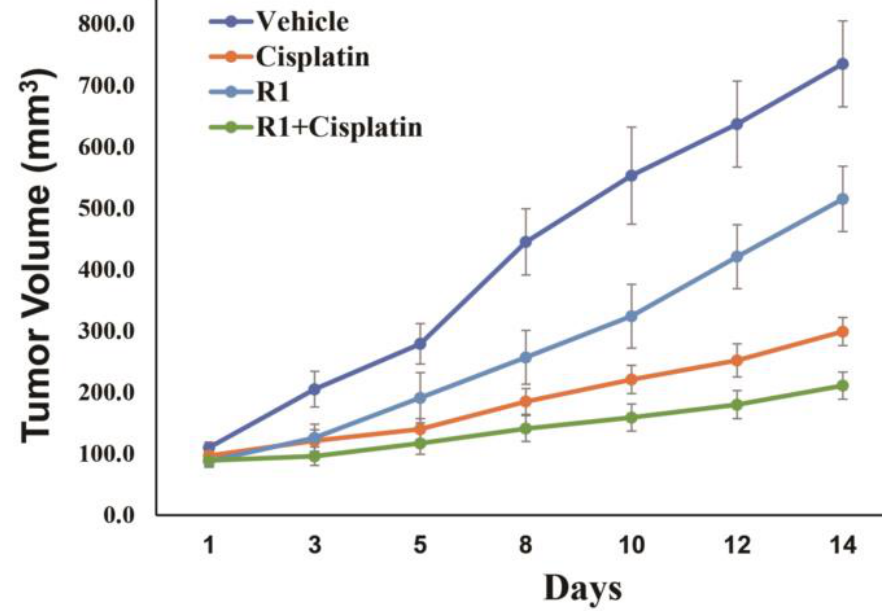
Figure 6. RAD51 inhibitor increases cisplatin sensitivity in EAC cells in vivo. OE19 cells were injected subcutaneously into SCID mice (5 mice per group) and following the appearance of tumors, mice treated with either DMSO, RAD51 inhibitor (RI-1; 25 mg/kg, 3 times/week for 2 weeks), cisplatin (3 mg/kg, once a week for 2 weeks) or in combination. Line plots showing tumor growth following different treatments are shown.